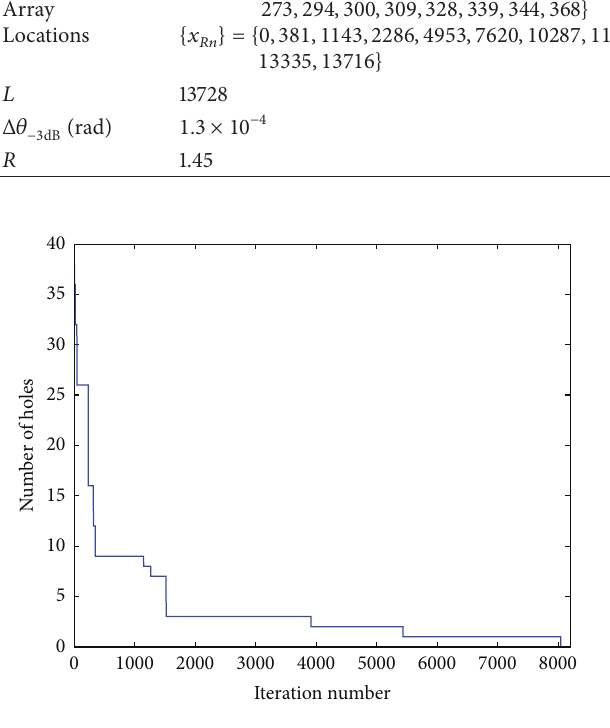
Figure 3: Minimum number of holes versus the number of iterations by using the PSO-based search.